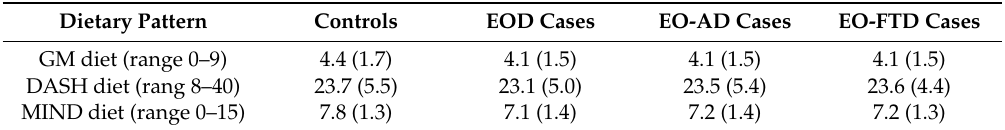
Table 2. Adherence to dietary patterns (Greek-Mediterranean (GM) diet; DASH: Dietary Approaches to Stop Hypertension (DASH) diet); Mediterranean-DASH Intervention for Neurodegenerative Delay (MIND) diet) in the study population (Early-onset dementia (EOD), early-onset Alzheimer’s dementia (EO-AD), and early-onset frontotemporal dementia spectrum (EO-FTD). Values reported as mean and standard deviation.